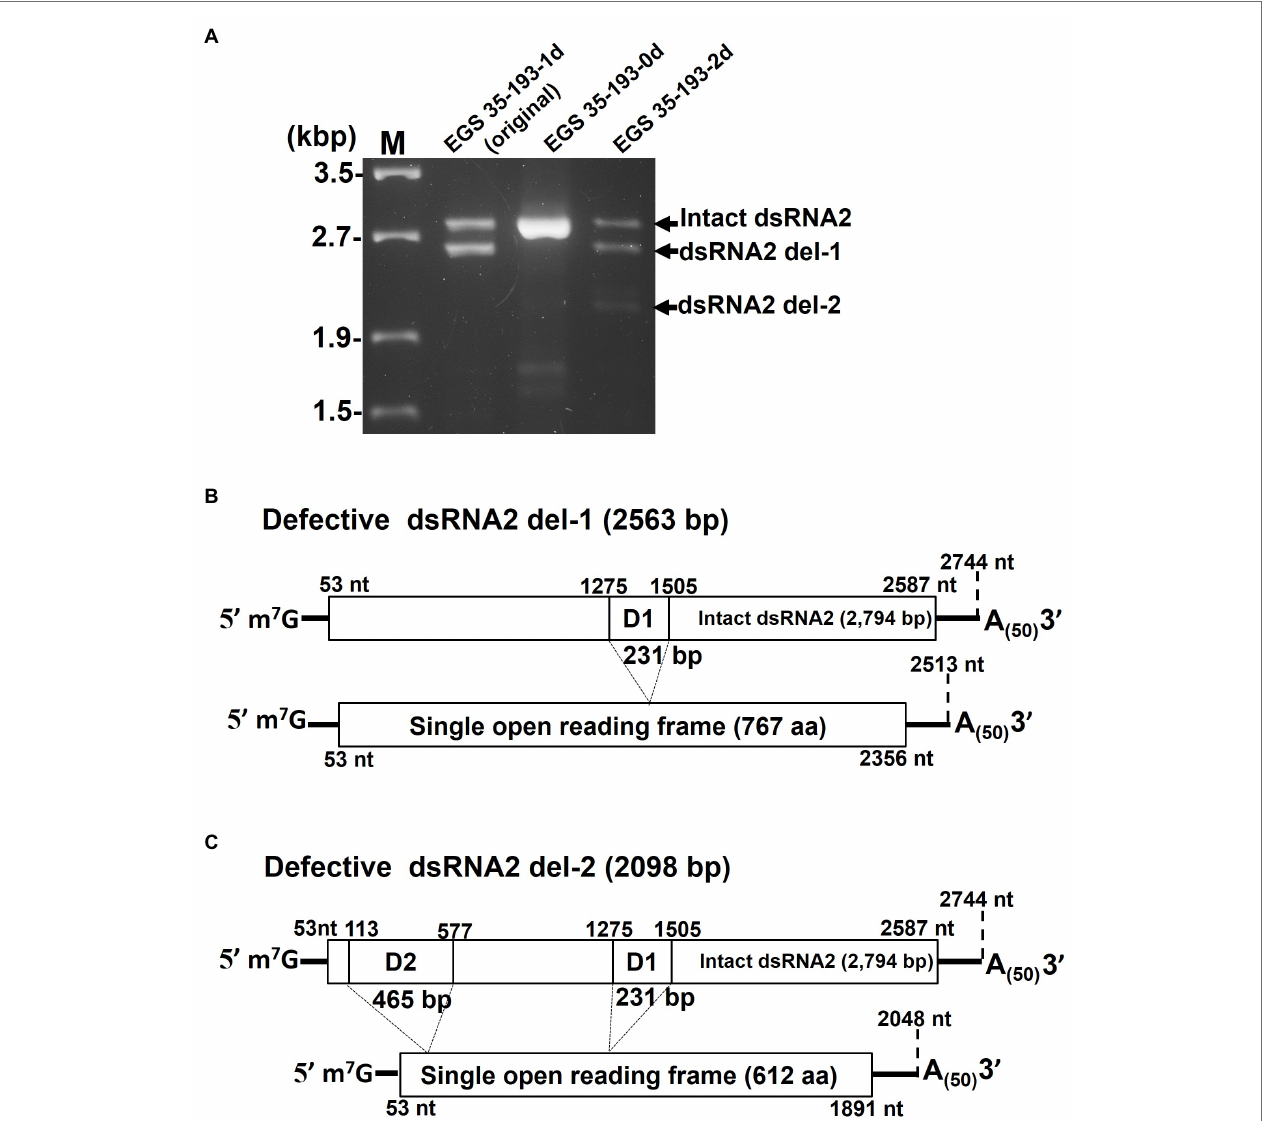
FIGURE 6 | Determination of the deleted regions in the dsRNA2 segments of AaV1. (A) Agarose gel electrophoresis of RT-PCR products amplified with the primer pair AaV1 dsRNA2-F and AaV1 dsRNA2-R, which is designed to amplify full-length AaV1 dsRNA2. The 1.0% agarose gel with EtBr (0.5 μ g/ml) was run at 18 V for 20 h. Lane M, 250 ng of λ -EcoT14I-digested DNA marker. (B, C) Schematic diagrams showing the genome deletions of the AaV1 dsRNA2 derivatives. (B) Defective dsRNA2 del-1 has an in-frame deletion site (D1, 231 bp) located at nt 1,275–1,505 of the intact AaV1 dsRNA2. (C) Defective dsRNA2 del-2 has two in-frame deletion sites, D1 and D2 (465 bp), located at nt 113–577 of the intact AaV1